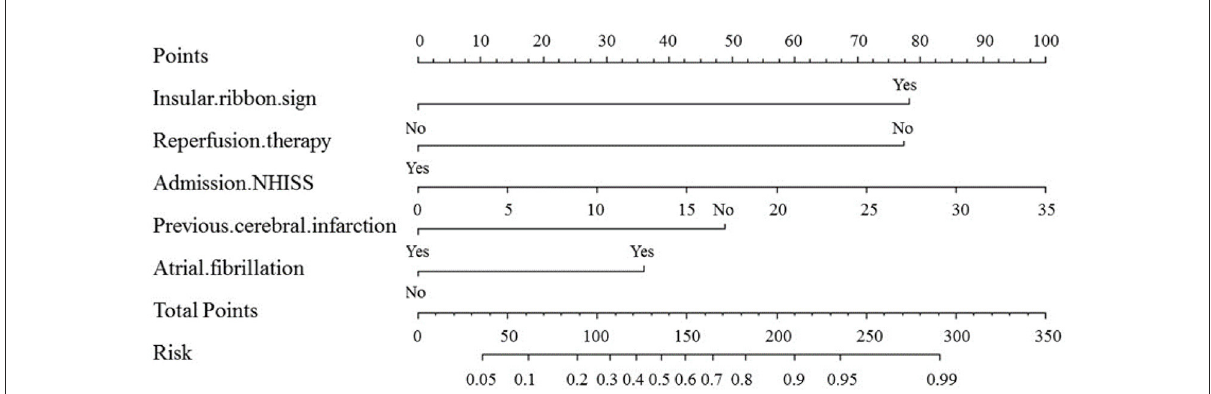
FIGURE2 Nomogram for predicting the probability of MCI based on insular ribbon sign, reperfusion therapy, NHISS, previous cerebral infarction and atrial fibrillation. Nomogram calculates the occurrence of MCI by assigning each predictive variable with scales in line segments and integrating the